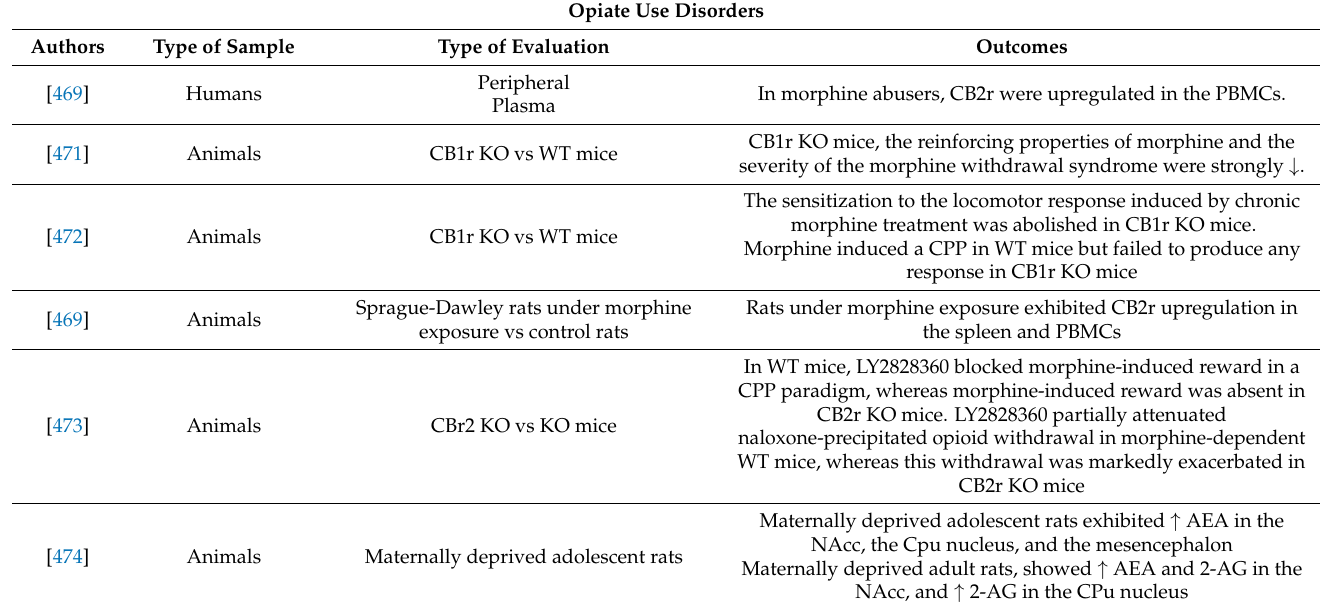
Table 5. Summary of main findings regarding the alterations of the ECS components in animals and human studies in Cocaine Use